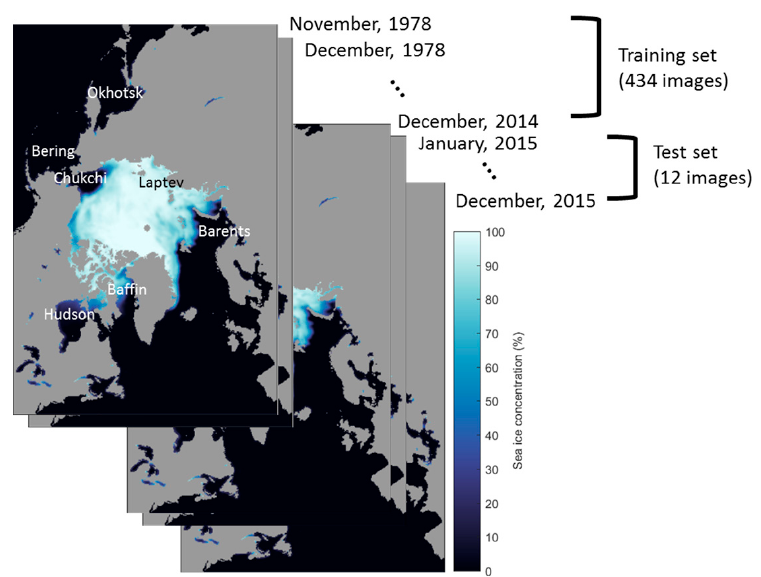
Figure 4. Description of SIC datasets for model training and forecasting.